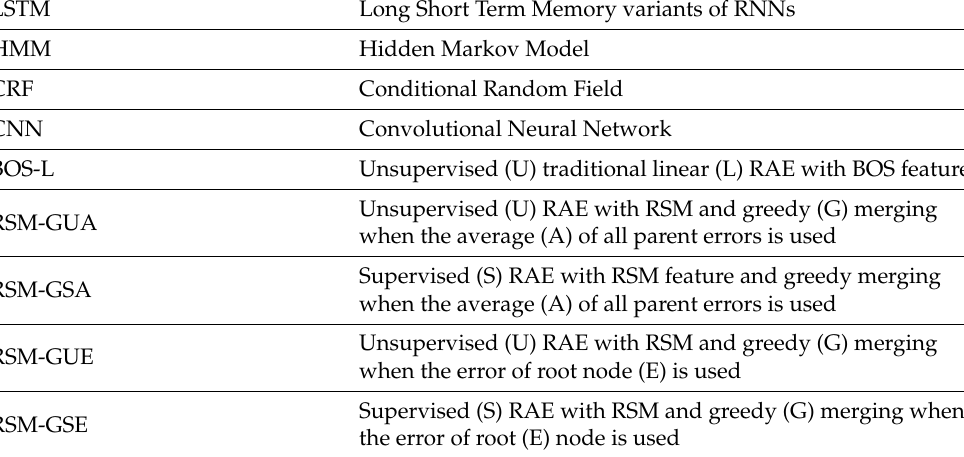
Table 1. Abbreviations of the models used.